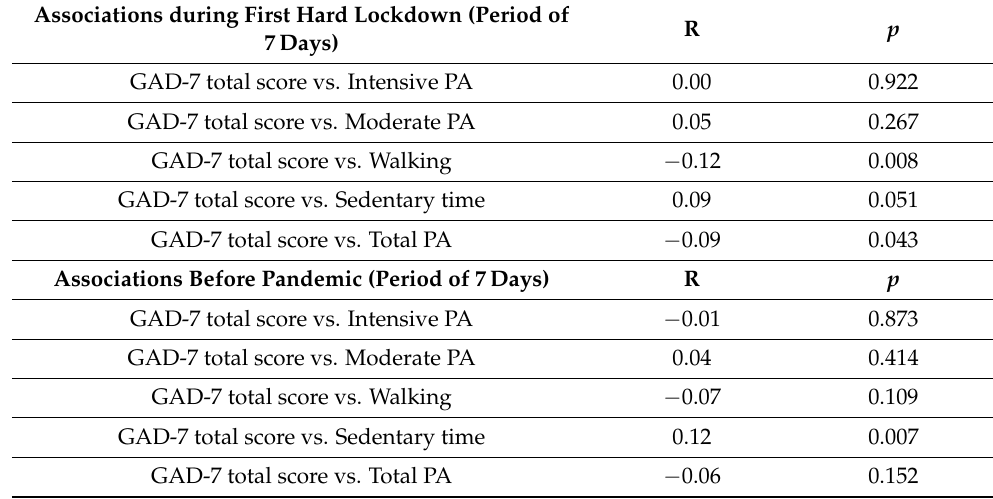
Table 5. Associactions between GAD-7 total score and physical activity during and before pandemic. Associations during First Hard Lockdown (Period